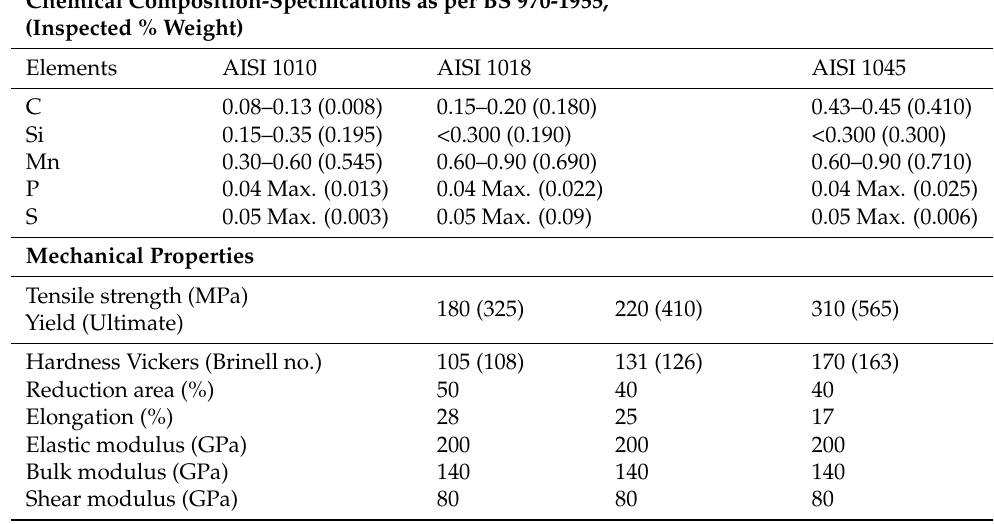
Table 1. Chemical composition and mechanical properties of steel